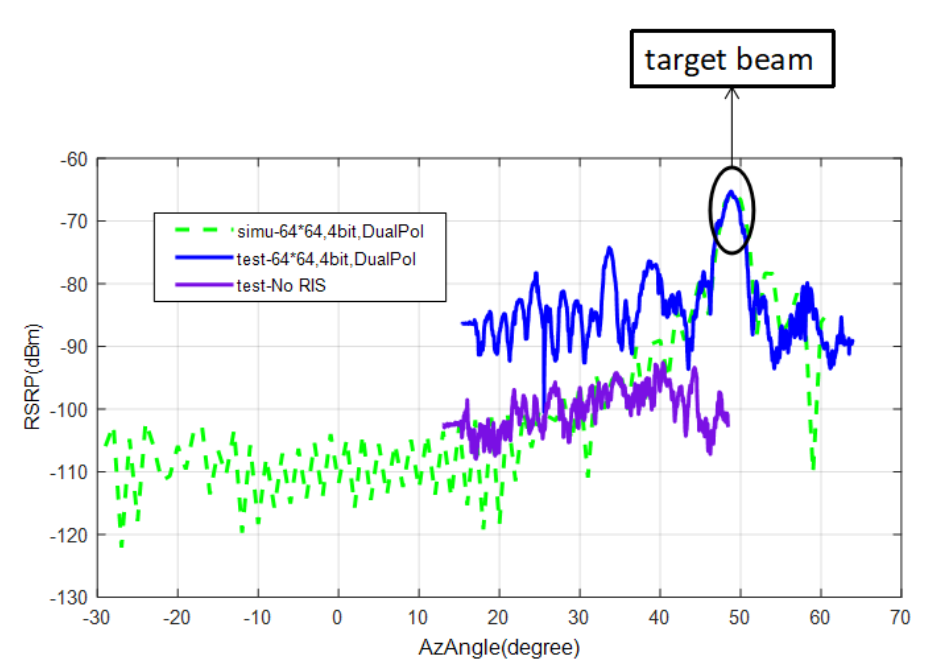
Figure 5. Comparison of the measured and simulated results of the 4-bit dual-polarized panel.